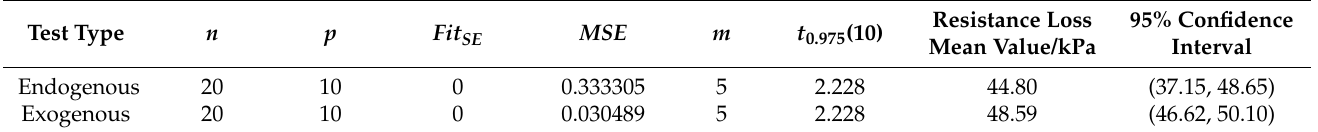
Table 13. Comparison of pipe transport resistance mean values and confidence interval